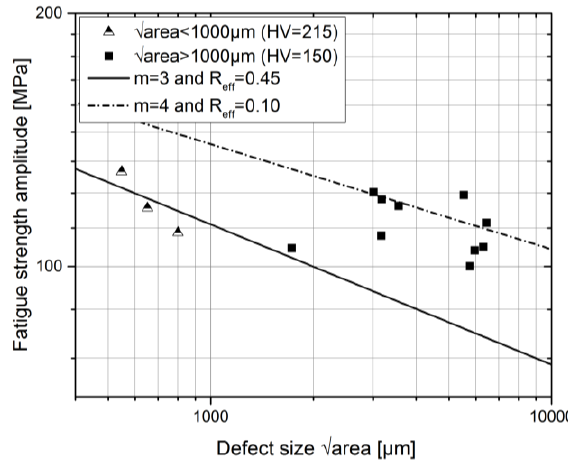
Figure 8. Fatigue strength amplitude based on model by Murakami [33] compared to test data.